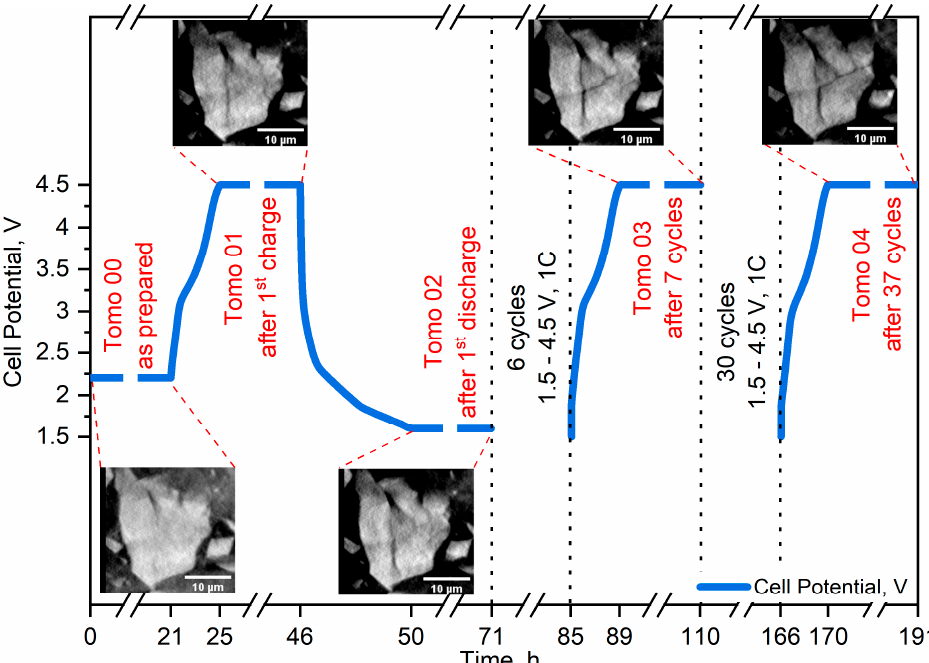
Figure 2. Electrochemical cell potential as a function of time, with “stopping points” for X-ray tomography studies denoted. Insets show characteristic virtual cross-sections. Only the first cycle and two further “stopping points” with virtual cross-sections are shown; the rest of the electrochemical process is represented as gaps.